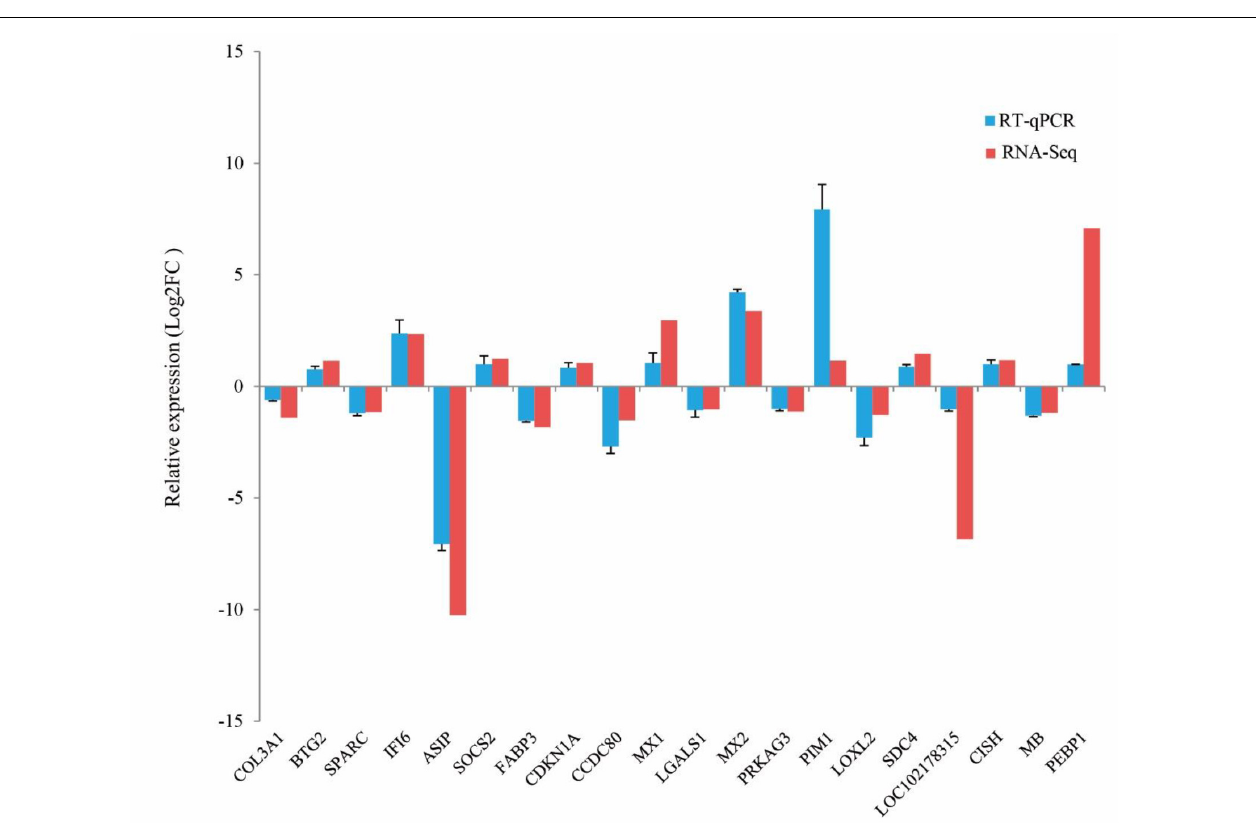
FIGURE 5 | Comparison of gene expression levels obtained by RNA-Seq, with those measured using RT-qPCR for 20 randomly selected DEGs. These contained ten up-regulated genes and ten down-regulated genes in ZB goats compared to LC goats. The expression level values for the RT-qPCR were normalized by GAPDH and β -actin genes. The error bars represent the variation in the five separate goats studied per